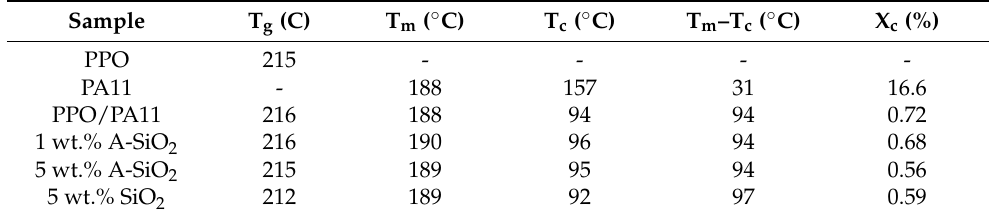
Table 5. Thermal properties of PPO, PA11, and PPO/PA11/silica composites, measured using